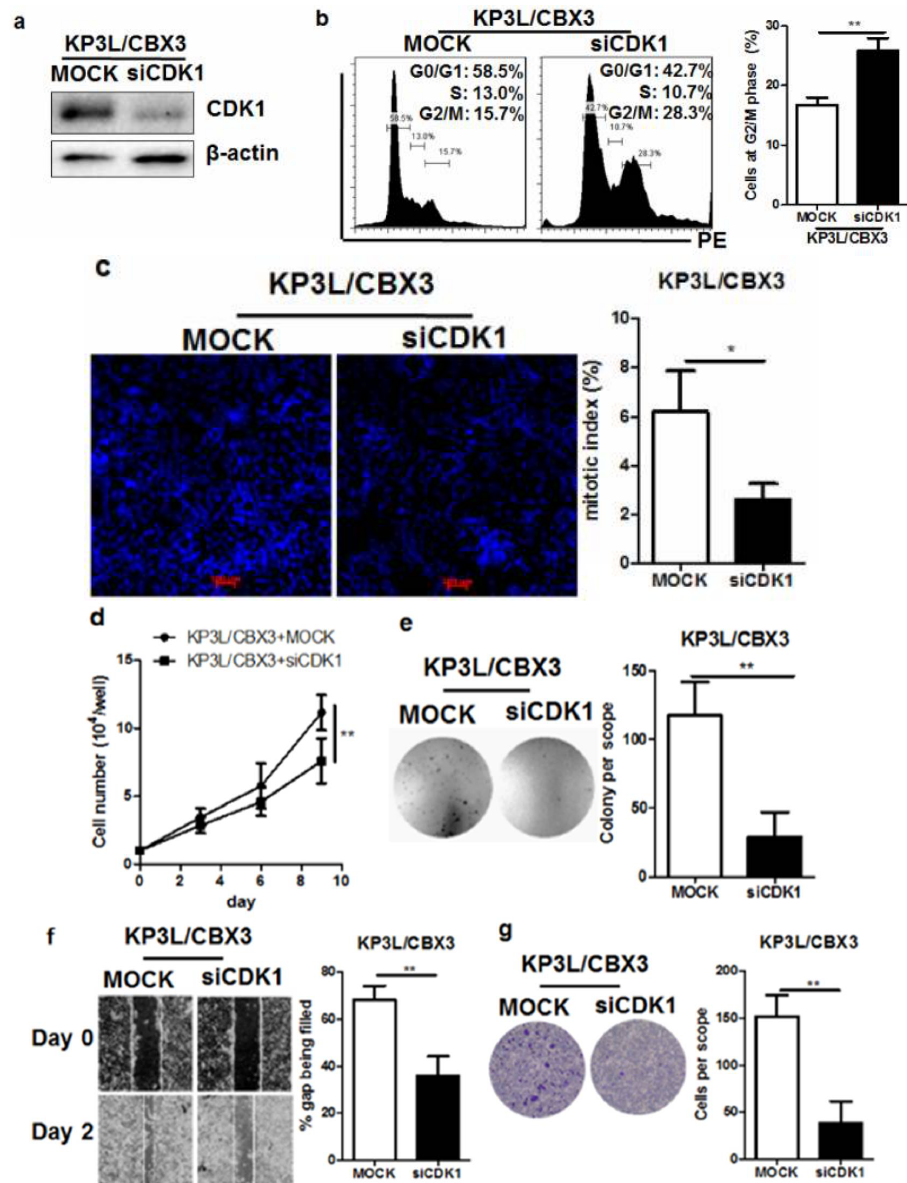
Figure 6. CDK1 mediated the tumor-promoting effect of CBX3 in PAAD cells. ( a ) Expression of CDK1